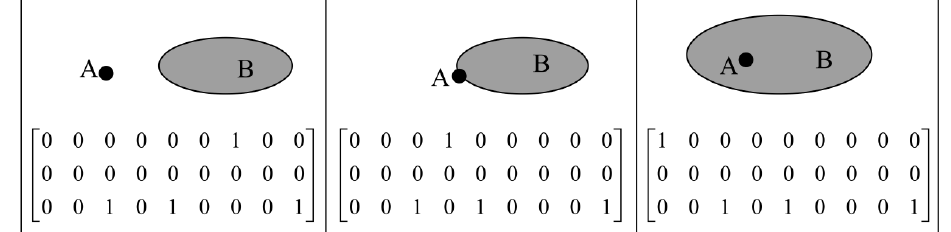
Figure 5. The formalism of the 27IM and the corresponding geometric interpretations between a point and a region.